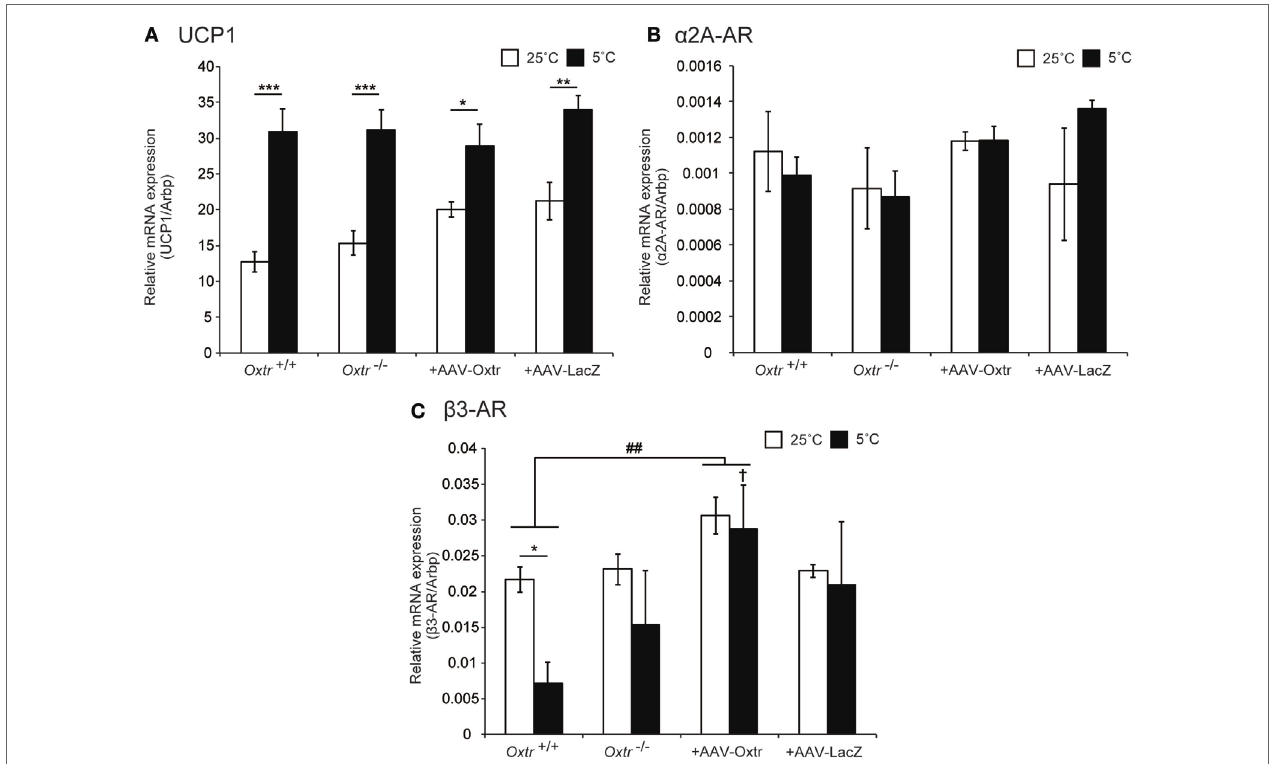
FigUre 4 | expression level of thermoregulation-related genes in BaT were quantified in Oxtr + / + , Oxtr − / − , + aaV-Oxtr, and + aaV-lacZ mice . (a) UCP1, (B) α 2A-AR, and (c) β 3-AR expression were measured by quantitative PCR analysis. Mice used for the preparation of mRNA were treated in 25 and 5°C conditions ( n = 5 for each groups and conditions). * p < 0.05, ** p < 0.01, *** p < 0.001, compared with 25°C condition; † , p < 0.05, compared with Oxtr + / + mice; ## , p < 0.01, significant difference between